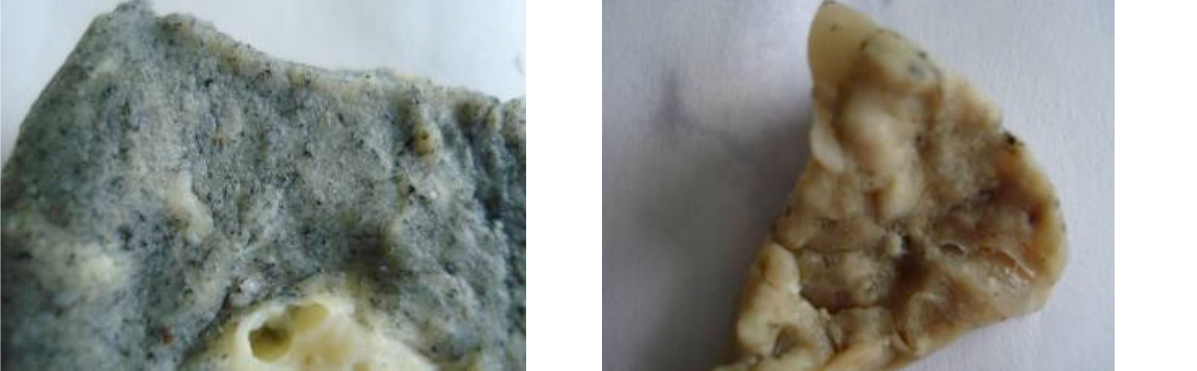
Image 6. Lung of Gayal showing caseous nodules and black-brown coloration